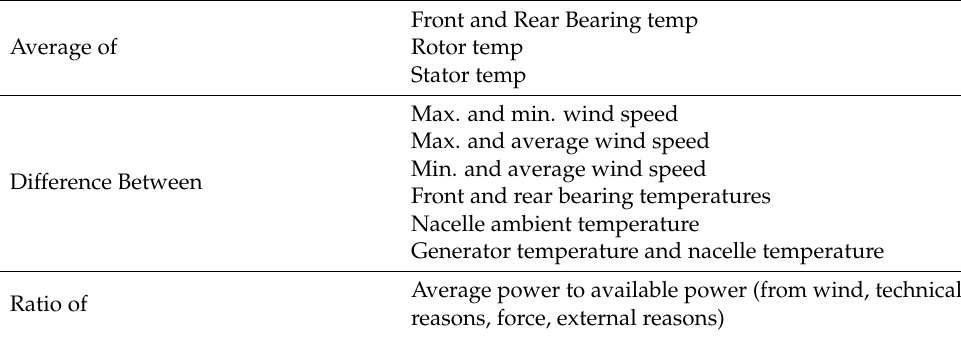
Table 2. Example Features from knowledge of WTs